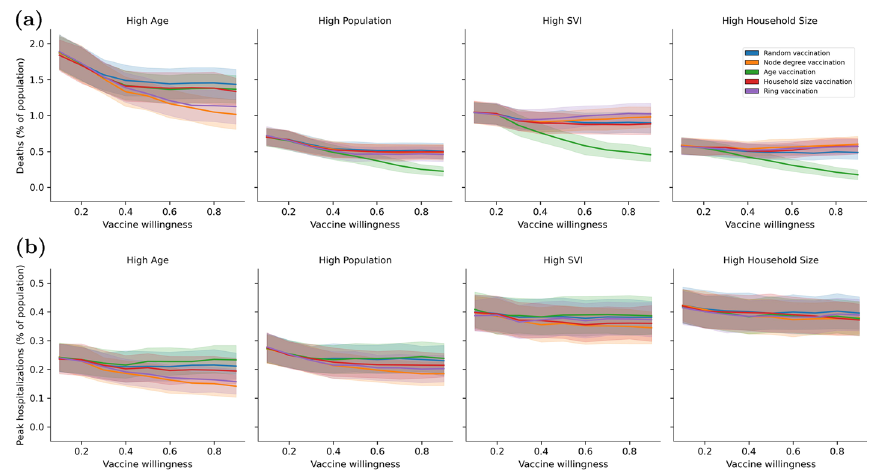
Fig. 11 Impact of vaccine willingness and vaccine strategies on a deaths and b peak hospitalization using Scenario 2 where mask effectiveness is